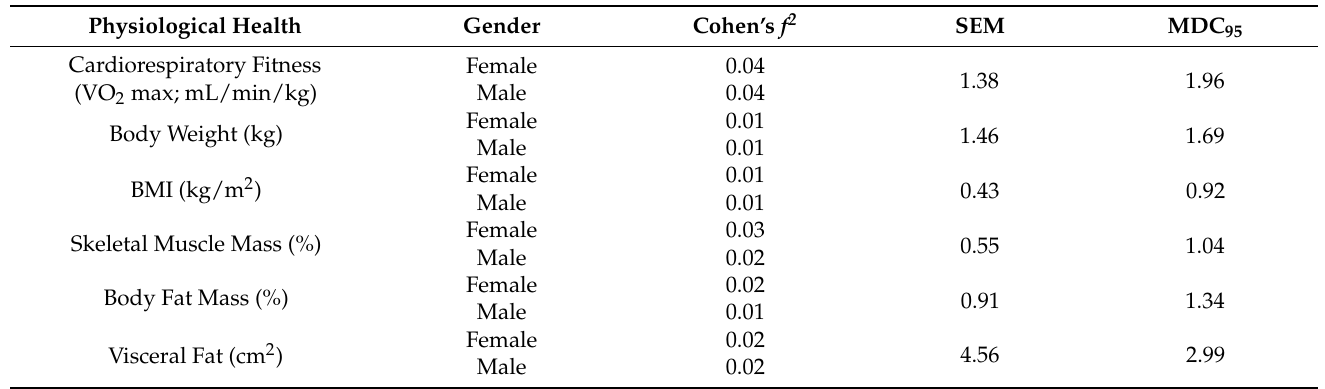
Table 4. Effect size, SEM, and MDC for all physiological health measures.